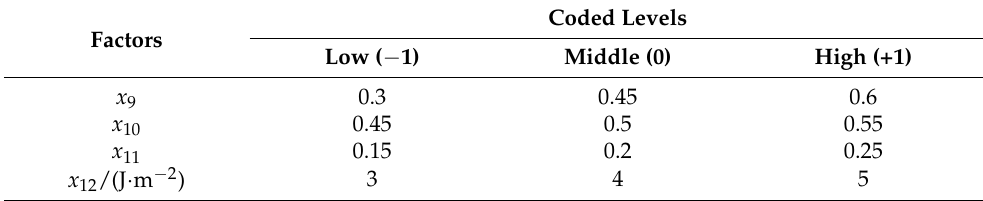
Table 4. Levels of factors for the BBD test of mixture AOR.